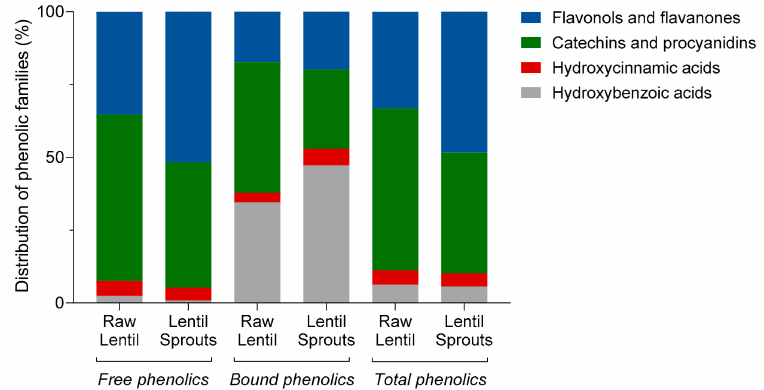
Figure 2. Distribution of di ff erent phenolic groups (hydroxybenzoic acids, hydroxycinnamic acids, catechins and procyanidins, and flavonols and flavanones) in the free, bound, and total phenolic fractions of raw and germinated